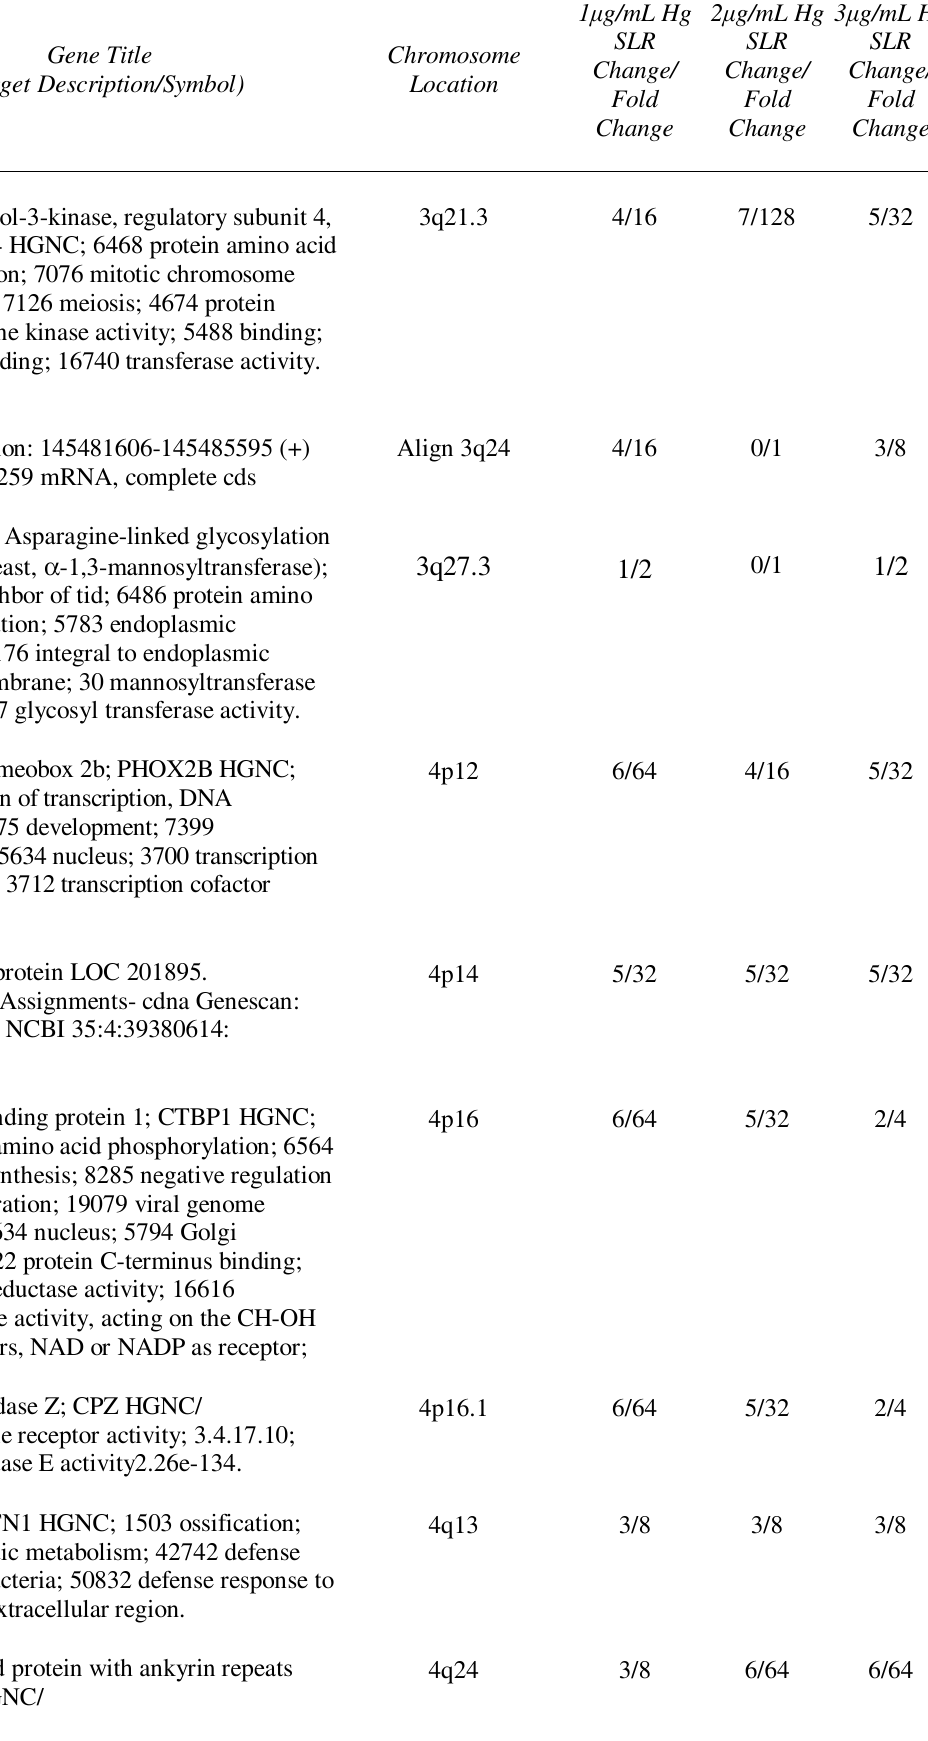
Table 1 contd.: Sample genes affected by mercury.